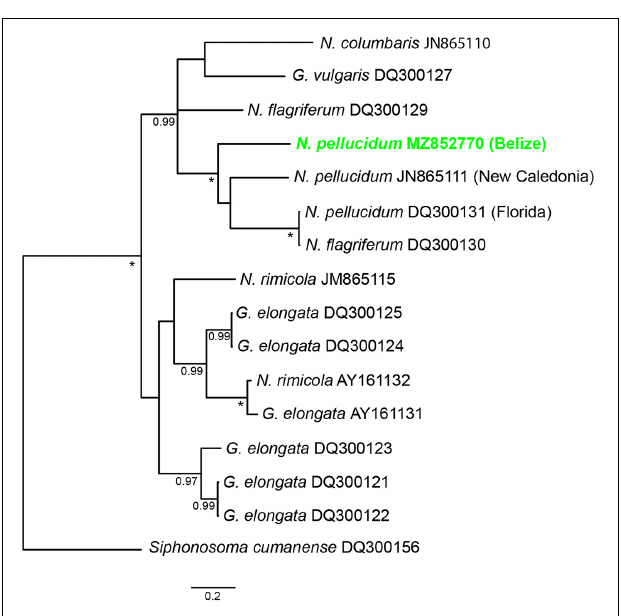
FIGURE 2 | 50% majority rule consensus tree resulting from Bayesian analysis of available COI sequences for Nephasoma and Golfingia species. Posterior probabilities over 90% are indicated at the notes; asterisks (*) indicate 100% posterior probability. All sequences are labeled with the species name and Genebank accession